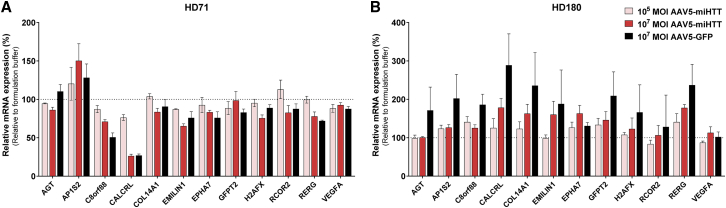
qPCR Analysis of Possible Off-Target Genes in Two Different HD Patient iPSC-Derived Neuronal Cultures(A) HD71. (B) HD180. HD patient iPSC-derived neuronal cultures were transduced with AAV5-miHTT at a MOI of 105 or 107, formulation buffer as negative control, and AAV5-GFP at a MOI of 107 as viral transduction control (n = 3). RNA was isolated and qPCR analysis was performed. Genes are normalized against the geometric mean of both housekeeping genes (ACTB and HMBS). Bars represent average ± SD of the percentage normalized expression with respect to formulation buffer-treated neuronal cultures. Data were evaluated using a paired Student’s t test versus formulation buffer control.